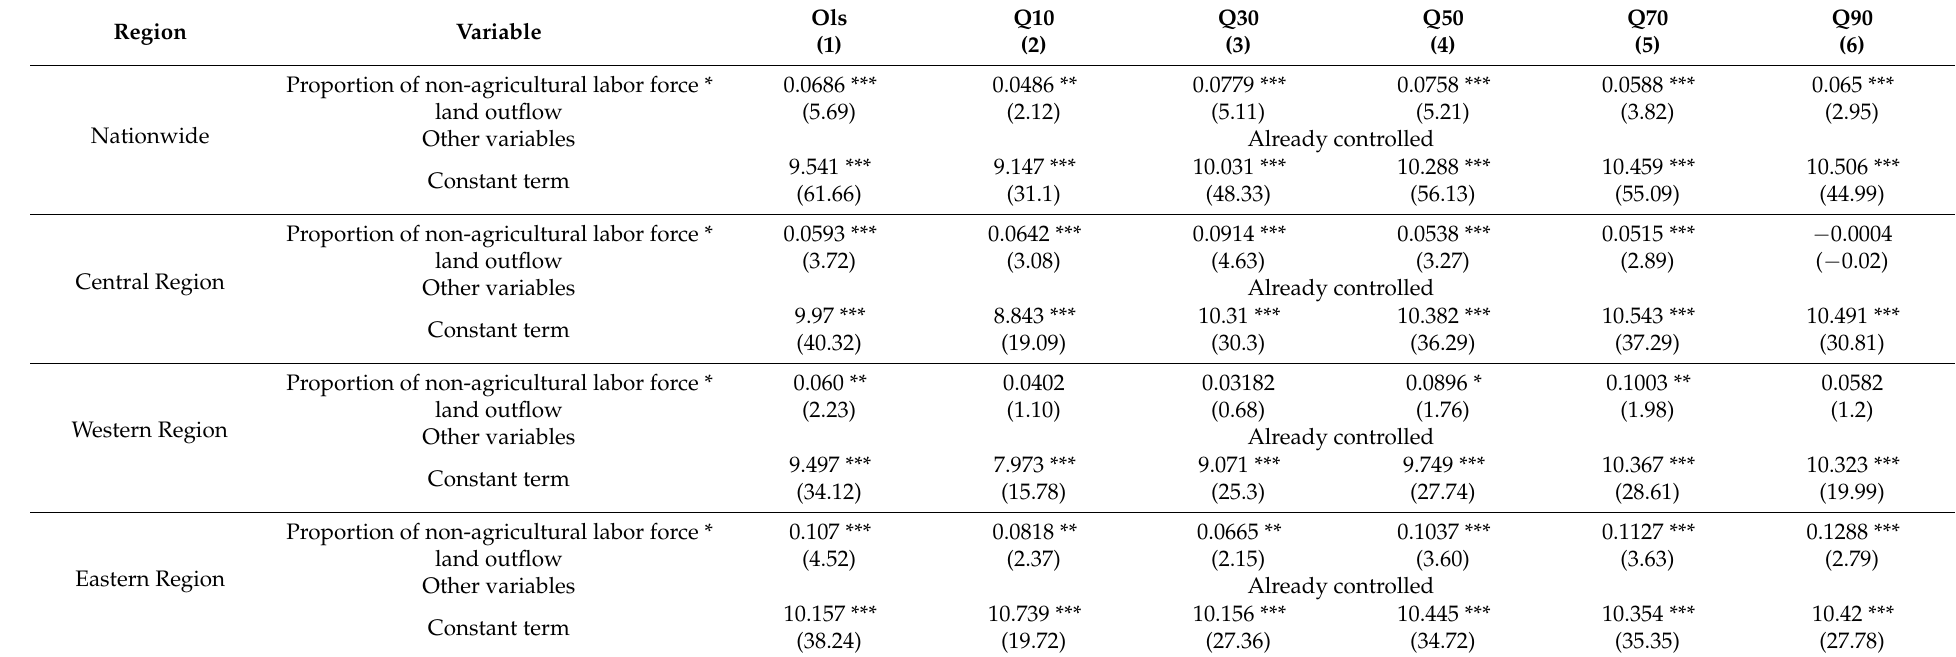
Table 4. Regression results of the dynamic relationship between labor mobility and land transfer outflow on the per capita disposable income of rural households by region. Region